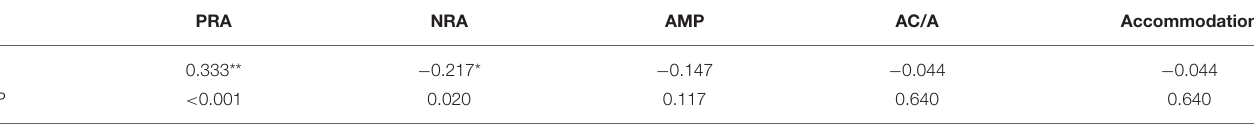
TABLE 3 | Correlation analysis of visual function on the growth rate of eye axial